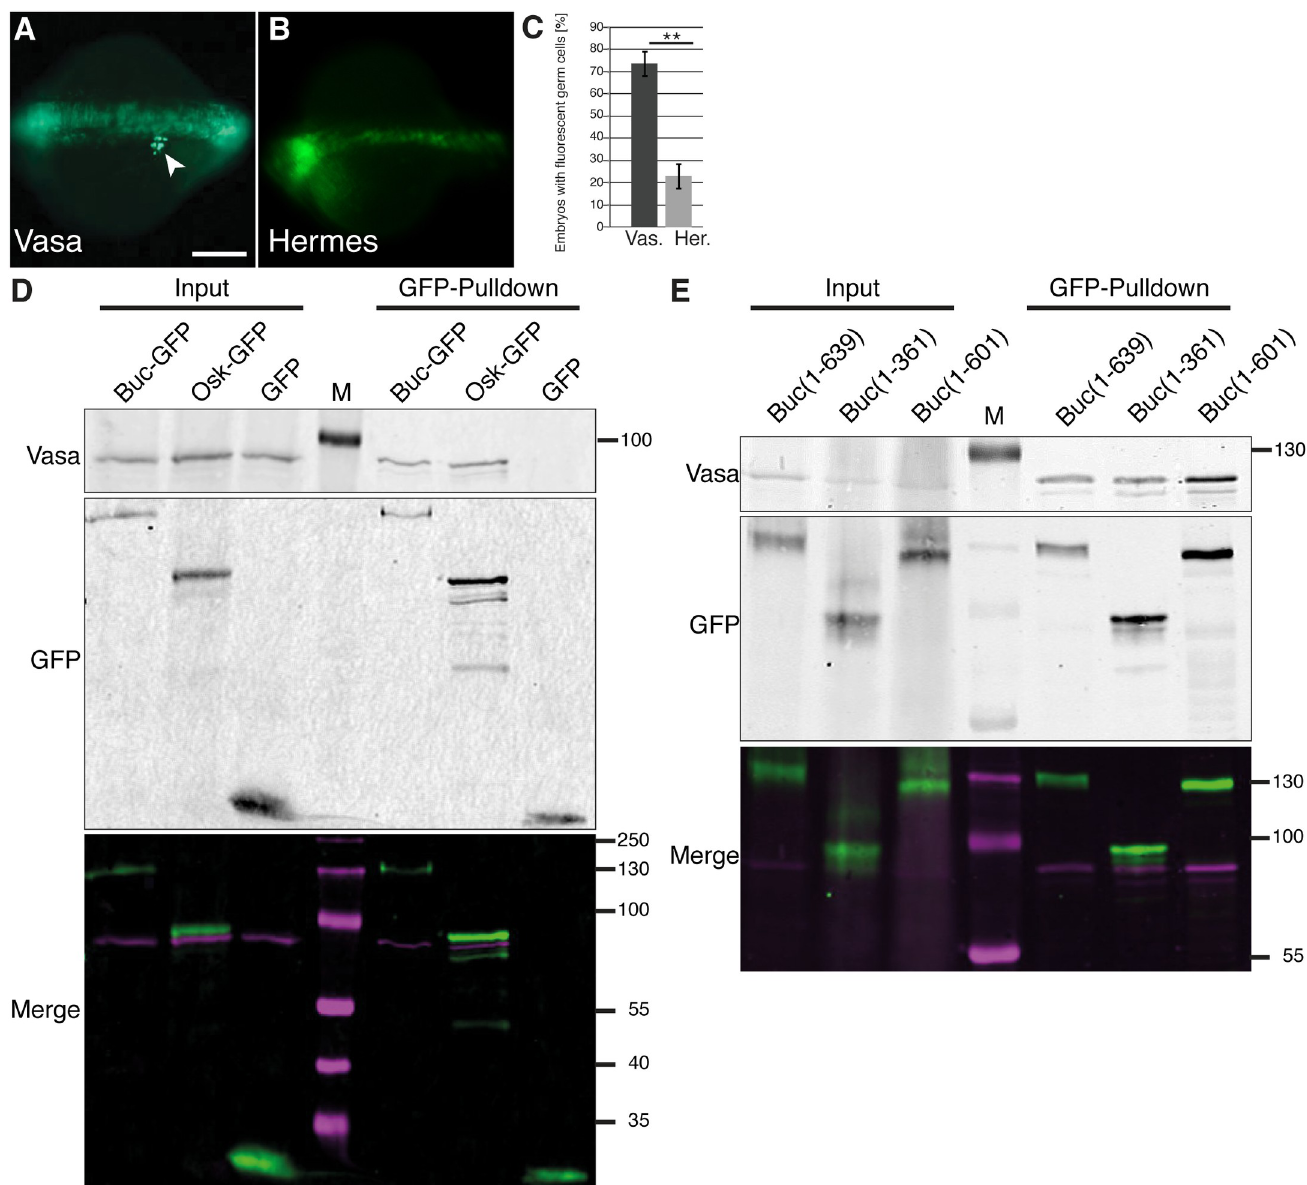
Fig 7. Zebrafish Vasa induces germ cells and binds to Drosophila Osk. (A-C) 16-cell assay showing germ cell formation (white arrowhead) after injection with vasa mRNA (A; 73.9 ± 5.3%; n = 60; p = 0.01) but not with hermes (B; 22.9 ± 4.8%; n = 60). Scale bar (A, B 200 μ m (C) Quantification of injection results (three independent experiments for each RNA). Error bars represent standard deviation of the mean. Student’s t-test; P-value: �� < 0.01. (D) Western blot of Buc-GFP, Osk-GFP, and GFP-control together with Vasa after in vitro translation (input = 40% of pulldown) and after GFP-pulldown. Vasa (upper panel, magenta in merged panel) interacts with Buc and Osk, but not GFP controls (middle panel, green in merged panel). (M: molecular weight marker lane) (E) Western blot of Buc-GFP, Buc p43 -GFP (1–361), and Buc p106 -GFP (1–601) (middle panel, green in merged panel) together with Vasa (upper panel, magenta in merged panel) after in vitro translation (input = 40% of pulldown) and after GFP-pulldown. Vasa interacts with Buc, Buc(1–361) and